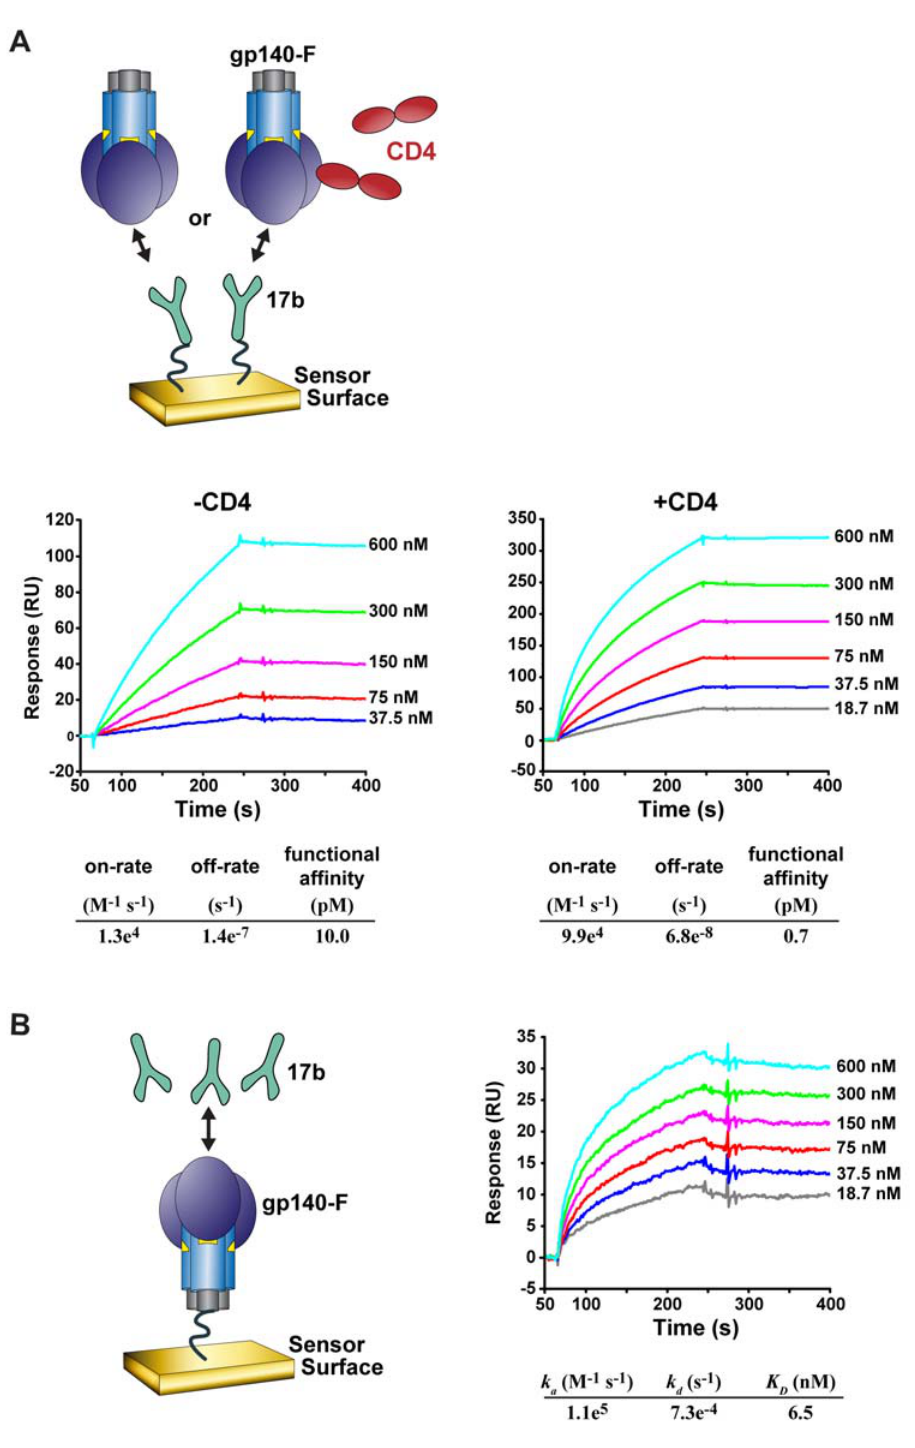
Figure 3. Biacore analysis of 17b:trimer interactions. The recognition of the gp140-F trimers by 17b IgG was assessed by SPR in two formats as shown. (A) 17b IgG was immobilized on the sensor surface and the trimers were then flowed over the Biacore chip either with or without pre- incubation with a 60-fold molar excess of D1D2 CD4. An approximation of the ‘‘functional affinity’’ of each interaction is presented as calculated by 1:1 Langmuir binding curve fitting. These values likely represent avidity due to the oligomeric state of the gp140-F trimers as the analyte. In this format, the off-rate value was difficult to accurately assess due to the very slow rate of dissociation and may overestimate the functional affinity or avidity. Nevertheless, this is clearly an avid reaction and the on-rates shown here agree with previous reports of the affinity values of monomeric gp120 recognition by monomeric 17b Fab, which is likely the best estimate of affinity [6]. (B) In the other orientation, the trimers were immobilized on the chip surface and 17b was used as the analyte. The affinity was calculated using bivalent curve fitting since the 17b IgG is dimeric. The value derived by this analysis indicates a high-affinity, low nanomolar interaction of the 17b IgG with the trimers in the absence of CD4, as shown.